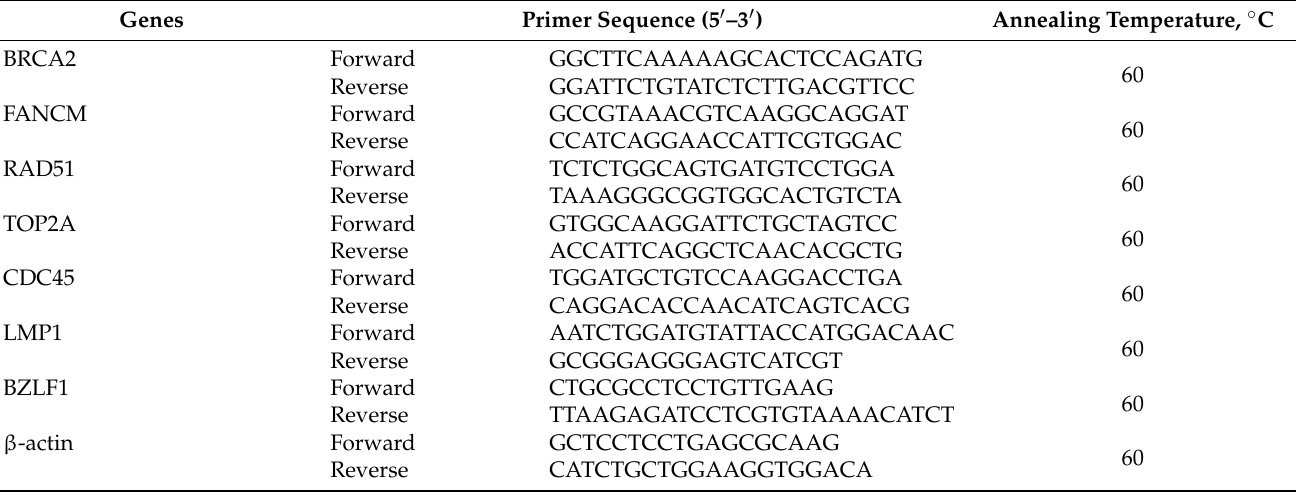
Table 3. Primers for quantitative real-time